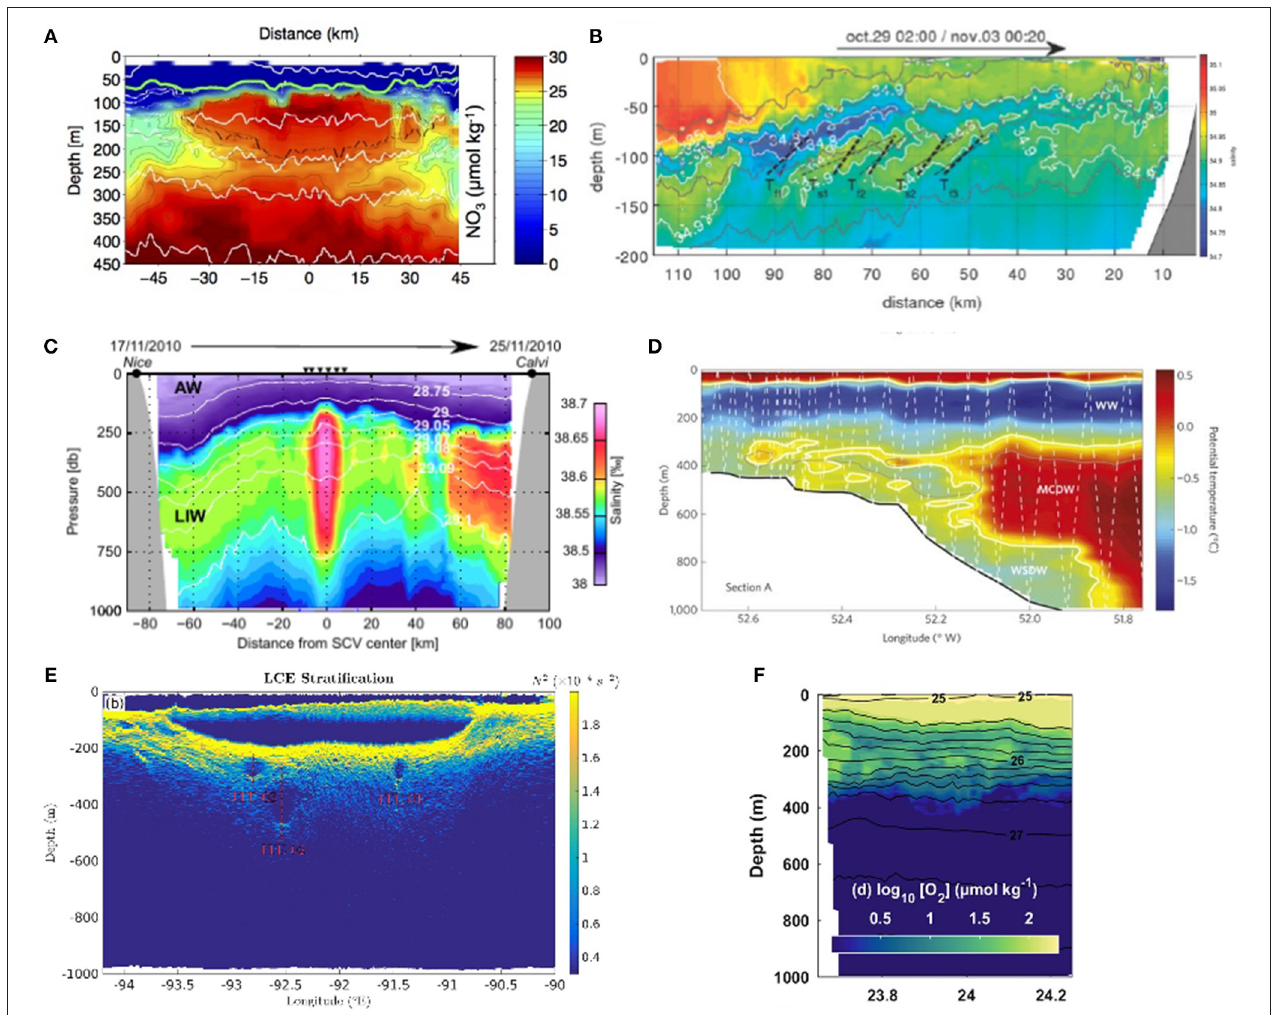
FIGURE 11 | Some highlights of (sub)mesoscale oceanic processes revealed by gliders that have been identified as important for the functioning of the physical, chemical and biological ocean: (A) Vertical section across a Dead Zone Eddy (DZE) showing its lens-like structure in nitrate concentrations (from Figure 7 of Karstensen et al., 2017); (B) Vertical section of salinity across the upwelling front off Peru (from Figure 7 of Pietri et al., 2013); (C) Vertical section across a SCV “Suddy” (from Figure 2 of Bosse et al., 2015); (D) Vertical section across the shelf of Antarctica peninsula (from Figure 1 of Thompson et al., 2014); (E) Vertical section across a LCE showing intrathermocline eddies (ITE) within (from Figure 11 of Meunier et al., 2018b); (F) Vertical section of dissolved oxygen in the Persian Gulf (from Figure 2 of Queste et al.,